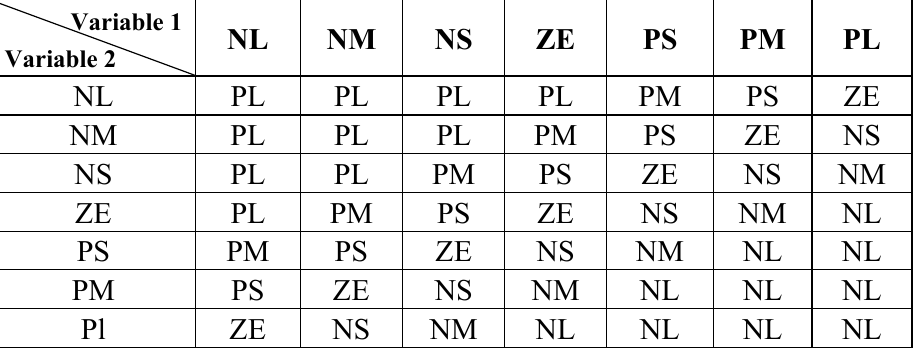
Table 2. Multi Input Single Output (MISO) Rule